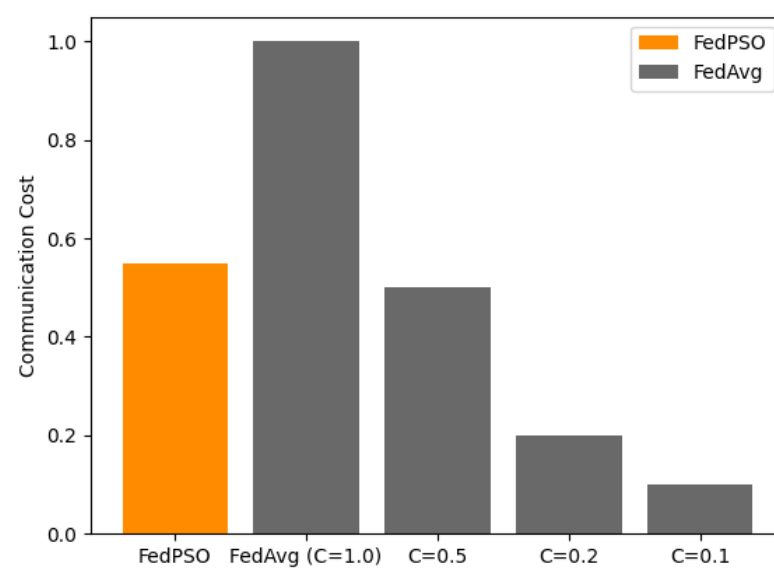
Figure 5. Communication Cost comparison of several